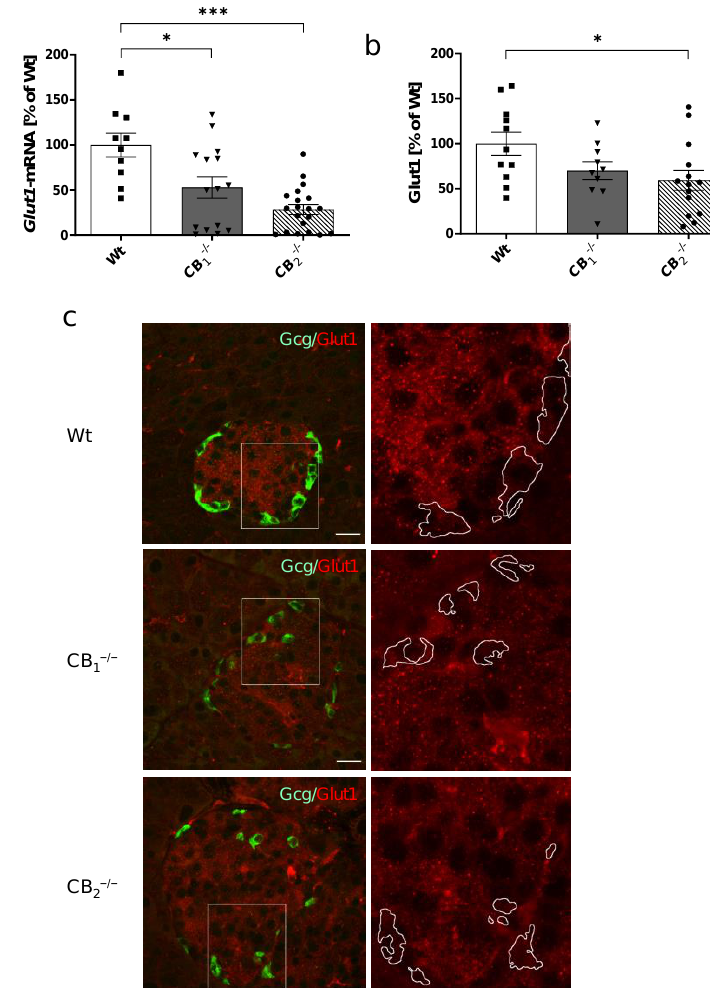
Figure 5. Analysis of glucose transporter 1 mRNA levels ( Glut1 ) and protein (Glut1) in pancreatic tissue of male and female wild-type (Wt) mice and cannabinoid receptor knockout mouse lines (CB 1 − / − , CB 2 − / − ). ( a ) Relative mRNA expression level of Glut1 was decreased in both knockout mouse lines ( n = 10–20). ( b ) In addition, protein content of Glut1 was also decreased in CB 1 − / − and CB 2 − / − mice ( n = 10–14). ( c ) Immunohistochemical staining of Glut1 (red) and colabelling of glucagon (Gcg, green) confirmed the localisation of Glut1 in both alpha- and beta-cells. A magnification of each islet (2.5 fold, box) is shown on the right column, and revealed the reduction of Glut1 in knockout mouse lines. In all cases, confocal optical sections were merged and are representative for pancreatic islets analysed in the whole pancreatic tissue from three mice per group. Values are presented as mean ( ± S.E.M.) and Wt values were defined as 100%. * p < 0.05; *** p < 0.001; unpaired t -test. Scale bar 20 µ m. Glut2 transcript levels were, although not statistically significant, decreased in knockout mice (Figure 6a). A nonsignificant reduction of Glut2 transcripts was seen in both male and female mice (Figure A1f). Considering Glut2 protein, a significant decrease was measured for CB 1 −/− and CB 2 −/− mice (Figure 6b). An overall significant decrease of protein was seen in both sexes (Figure A3b). Immunohistochemistry revealed the labelling of Glut2 to be predominant in pancreatic islets and, more specifically, in pancreatic beta-cells restricted to the cell membrane (Figure 6c). Knockout mice yielded weaker immunostaining of the membranes, but increased cytoplasmic labelling, as seen by small dots in the cytoplasm. In CB 2 −/− , this altered pattern was more accentuated, showing more accumulations in the cytoplasm and a modified appearance of the membrane structure.